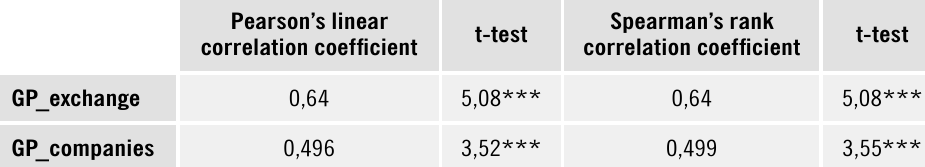
Table 3. Values of correlation coefficients between OF and GP _ exchange and GP _ companies Pearson’s linear Spearman’s rank t-test t-test correlation coefficient correlation coefficient GP_exchange 0,64 5,08*** 0,64 5,08*** GP_companies 0,496 3,52*** 0,499